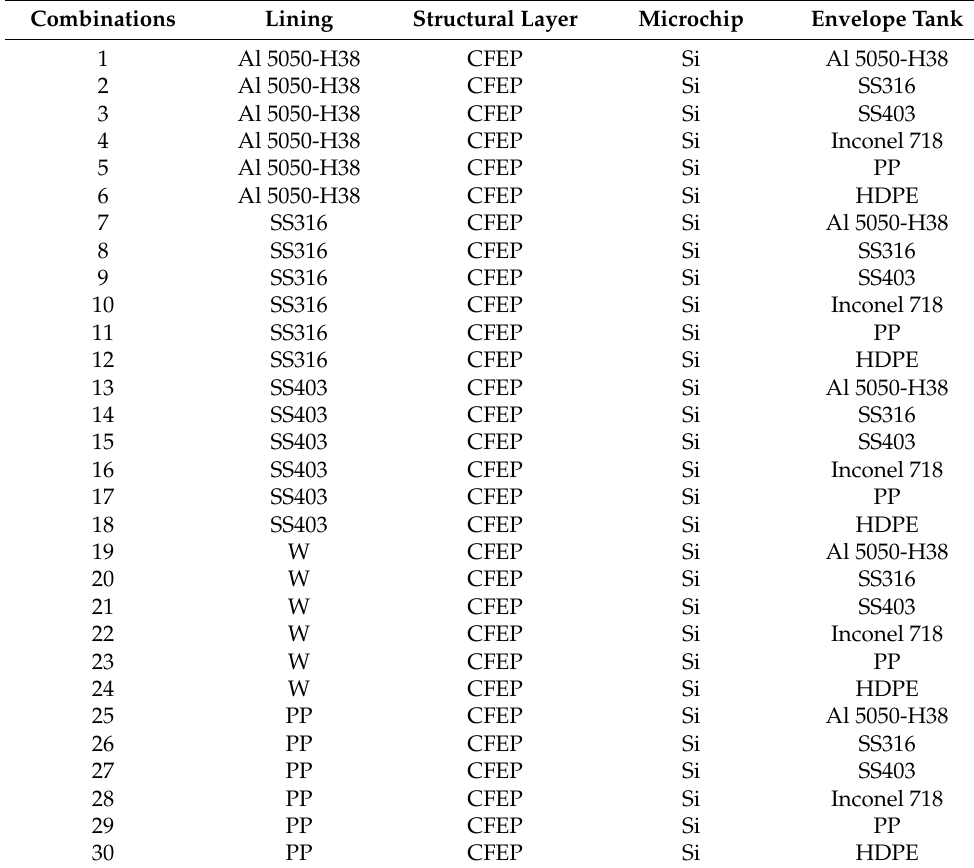
Table 3. Combinations of material for each part of the storage system studied. Combinations Lining Structural Layer